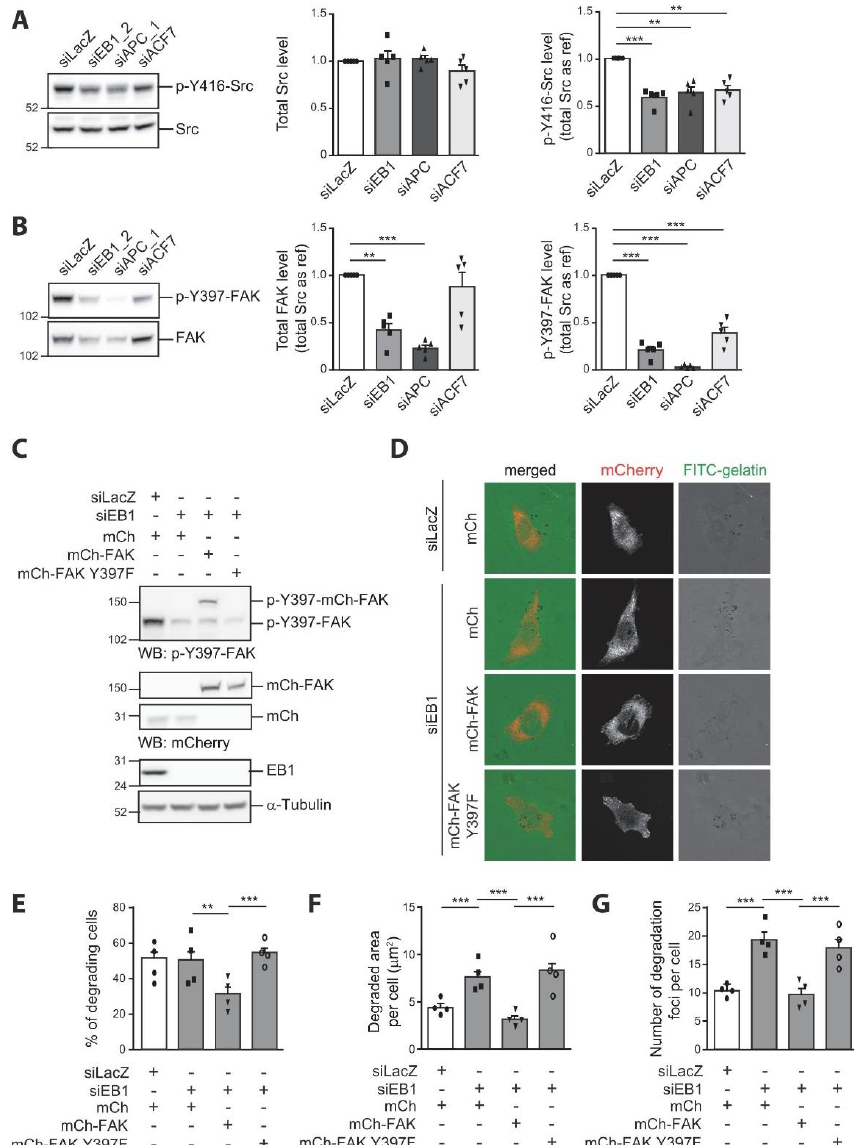
Figure 4. EB1 restricts invadopodia formation via inhibition of FAK activity. ( A , B ) MDA-MB-231 cells were transfected with a control siRNA (siLacZ) or siRNA directed against EB1 (siEB1_2), APC (siAPC_1) and ACF7 (siACF7). Levels of Src, activated Src (p-Y416-Src), FAK and FAK phosphorylated on Tyr397 (p-Y397-FAK) were analyzed by Western blotting using specific antibodies. ( A ) Total Src and p-Y416-Src levels are represented as the mean ± SEM of five independent experiments. The value of each individual experiment is reported. A representative Western blot is shown (left). ( B ) Total FAK and p-Y397-FAK levels are represented as the mean ± SEM of five independent experiments. The value of each individual experiment is reported. A representative Western blot is shown (left). Src was used as a loading control and as a reference to quantify p-Y416-Src, total FAK, and p-Y397-FAK levels. The paired t -test was used to determine significant differences. *** p ≤ 0.001, ** p ≤ 0.01. ( C – G ) MDA-MB-231 cells stably expressing mCherrry, mCherry fused to wild type FAK or mCherry fused to the SH2-binding motif mutant of FAK (FAK Y397F) were transfected with a control siRNA (siLacZ) or a siRNA against EB1 (siEB1) before seeding on fluorescently-labeled gelatin (FITC-gelatin) for 4 h. ( C ) Levels of p-Y397-FAK, mCherry fusion proteins, and EB1 were analyzed by Western blotting (WB) using specific antibodies. α -Tubulin serves as a loading control. ( D ) Representative images of cells fixed and stained with anti-mCherry and anti-Cortactin (not shown) antibodies. The percentage of mCherry positive degrading cells ( E ), the degraded area per cell ( F ), and the number of degradation foci ( G ) are represented as the mean ± SEM of four independent experiments. The mean of each individual experiment is reported. Statistical analysis was performed as described in Figure 1. Full-length blots are presented in Supplementary Figure